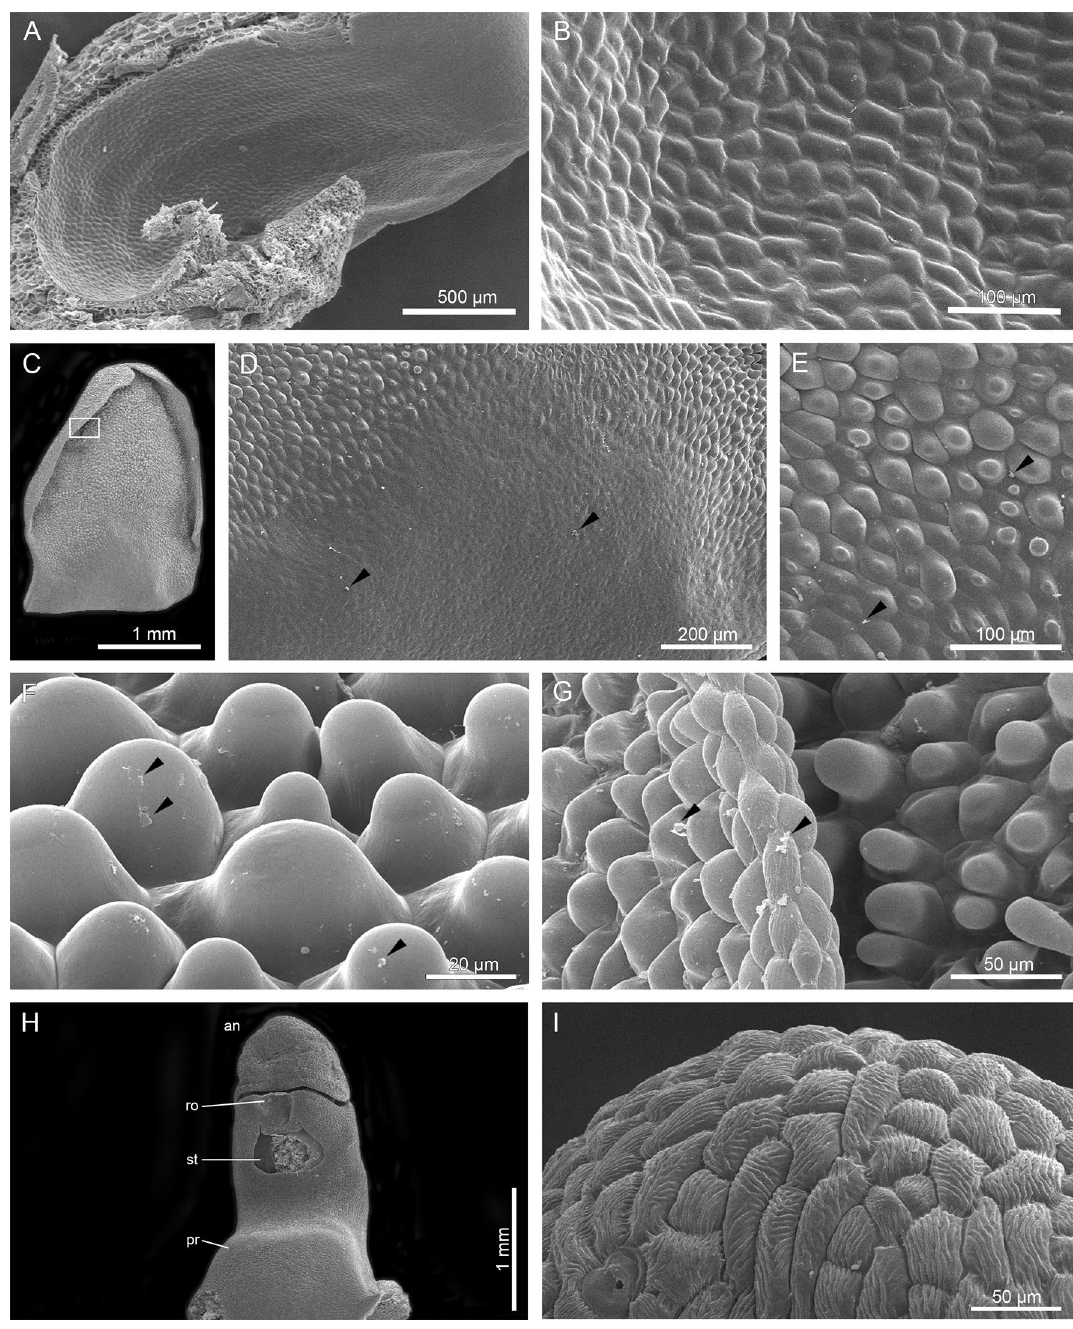
Figure 3. Micromorphological features of the lip (SEM): ( A ) Lip: the inner surface of the saccate base; ( B ) The inner surface—details of A; ( C ) Lip: the glabrous middle part passing into a papillate, distal part—densely papillose with conical and obpyriform papillae and curved margins; ( D , E ) Details of the middle part showing the passage from glabrous to papillose surface, remnants of secretions ( arrows ); ( F ) The distal part with obpyriform papillae with residues of secreted material ( arrows ); ( G ) Lip margin and papillae at distal part, with residues of secreted material ( arrows ), detail of ( C ); SEM studies of gynostemium. ( H ) The stout gynostemium equipped with a swollen mound/protuberance ( pr ) at the base, an —anther cap, ro —rostellum, st —stigma; ( I ) Anther cap glabrous, with a strongly striate cuticle and visible